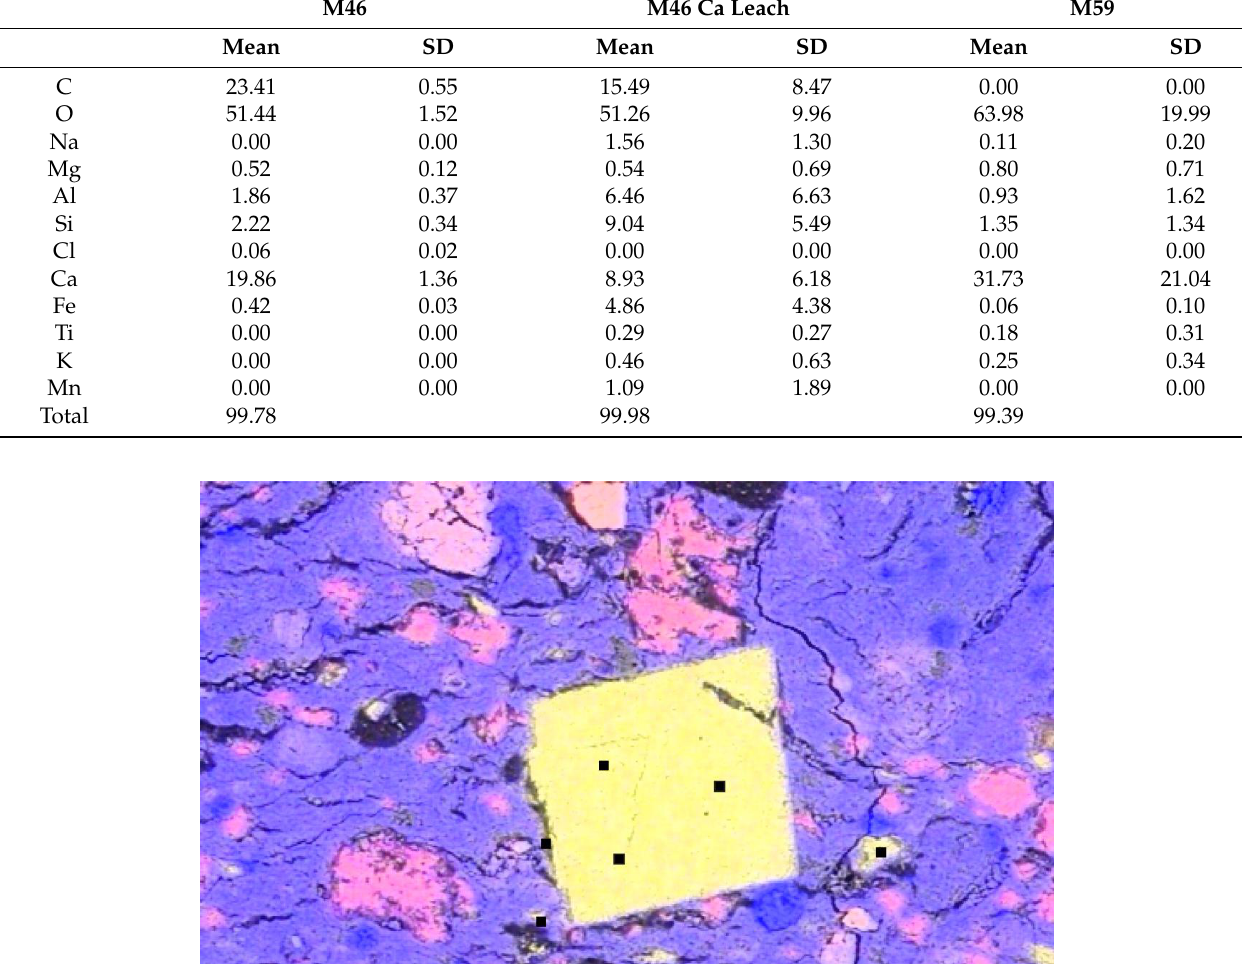
Table 2. Mean EDS elemental concentrations for assumed calcite grains and Ca leaching in M46 and M59. Data expressed in atomic percentages (at%). M46 M46 Ca Leach